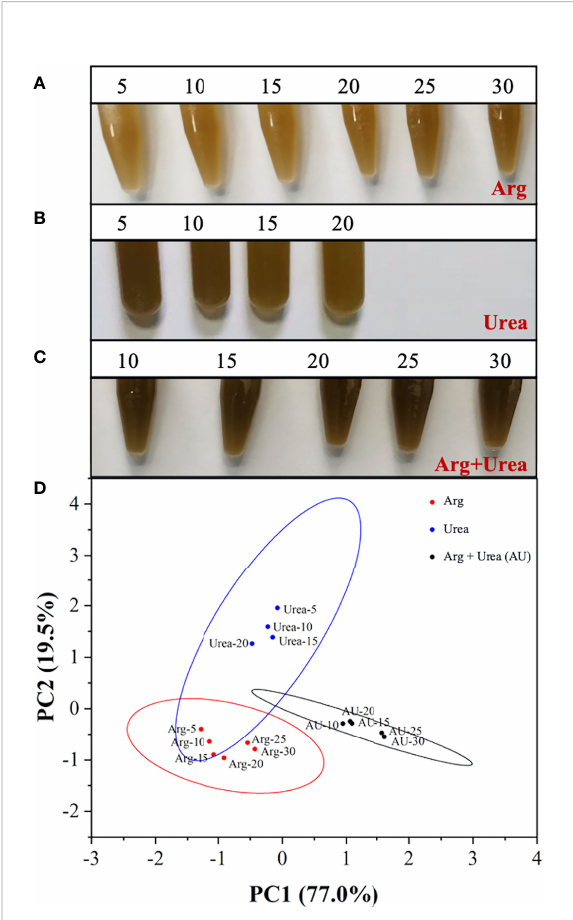
FIGURE 5 The images of the mixotrophic Phaeodactylum tricornutum at the end of cultivation using (A) Arg (5, 10, 15, 20, 25, 30 mmol N L − 1 ), (B) urea (5, 10, 15, 20 mmol N L − 1 ), and (C) the mixture of Arg and urea (10, 15, 20, 25, 30 mmol TN L − 1 , in which urea was at 5 mmol N L − 1 ) as nitrogen source and (D) score plot of the principal component analysis (PCA) for cell growth performance and pigment